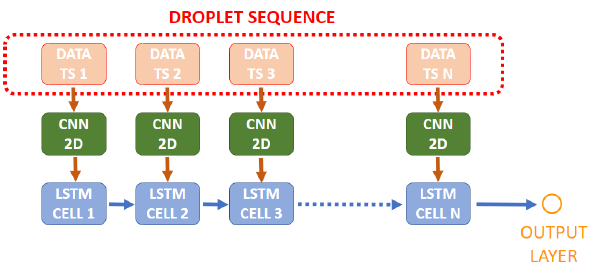
Figure 6. LSTM + CNN2D architecture scheme. The CNN represented by the green boxes is the same applied to every frame in the sequence. TS denotes time step. Each time step corresponds to a different frame in the